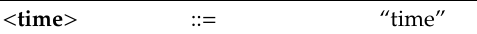
Table A11. The 1st stage of < time > .